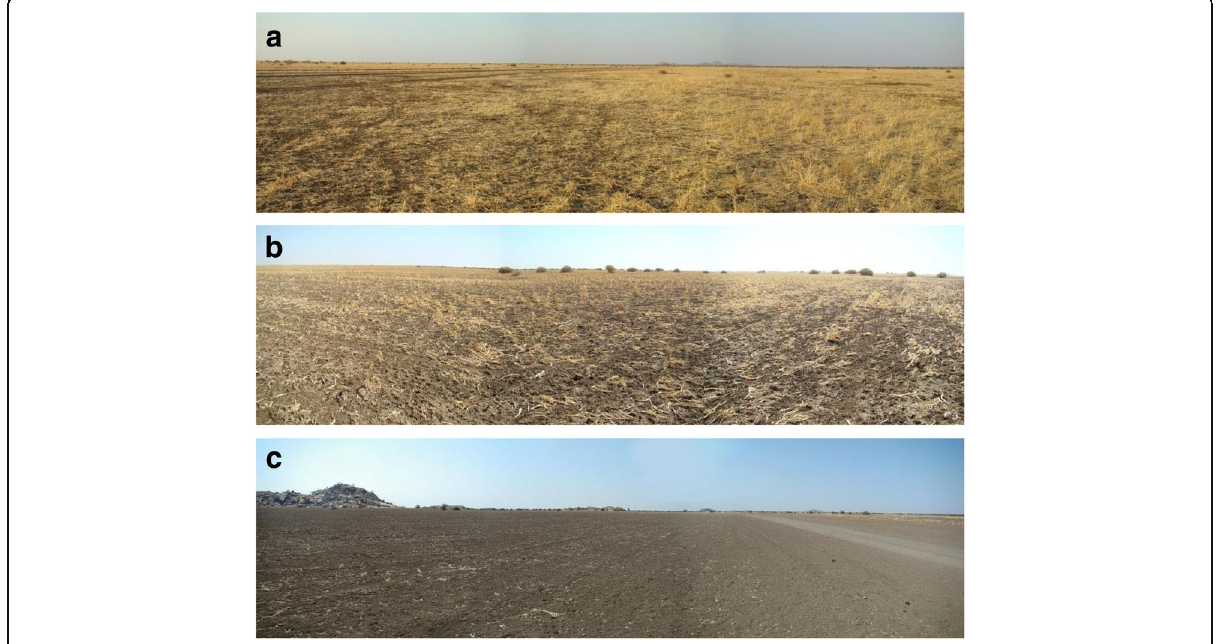
Figure 2 Selected panoramic photos from Elgegi Valley taken in the dry season, April 2015. a Area where unpalatable species dominate, the grass cover remains standing and retains a yellow-brown colour throughout the dry season. b A LSMA site covered with crop residue